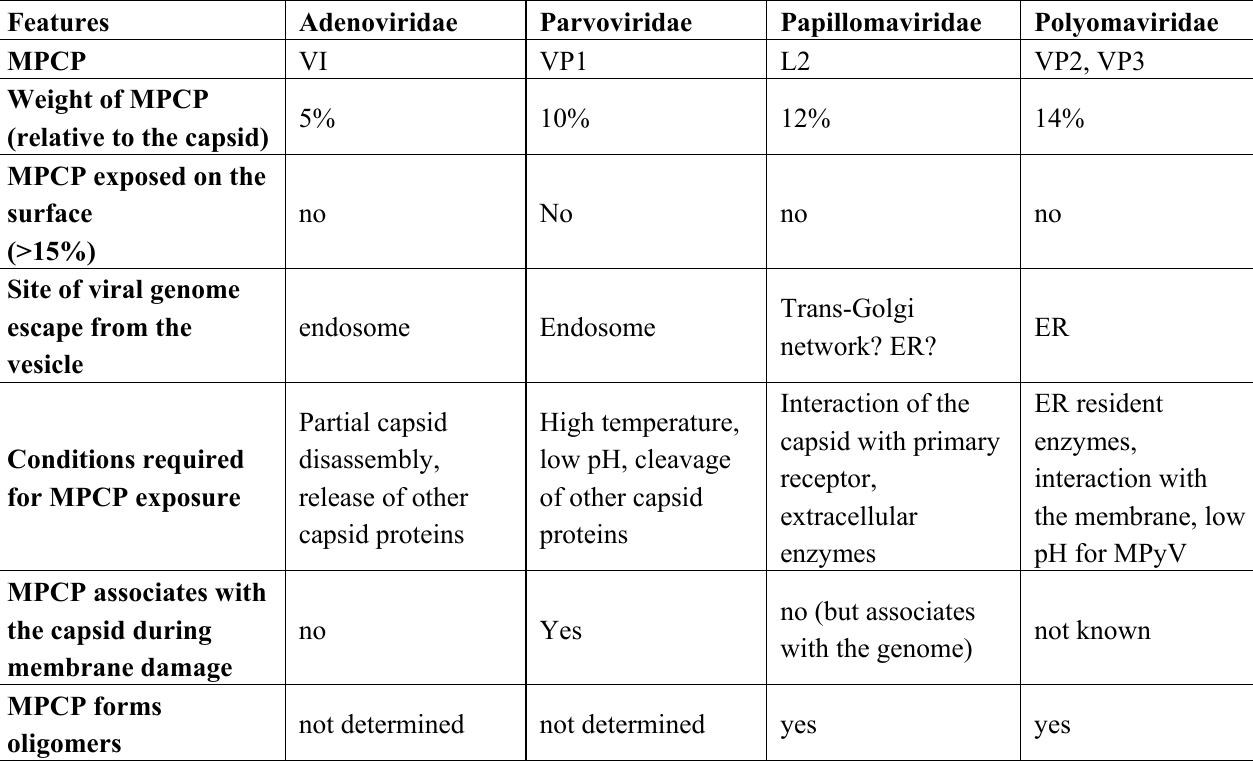
Table 3. Comparison of features of membrane penetration capsid proteins (MPCP) relevant for transmembrane translocation of non-enveloped DNA viruses during early stages of infection. Some features are based on the current models and proposed mechanisms described in the